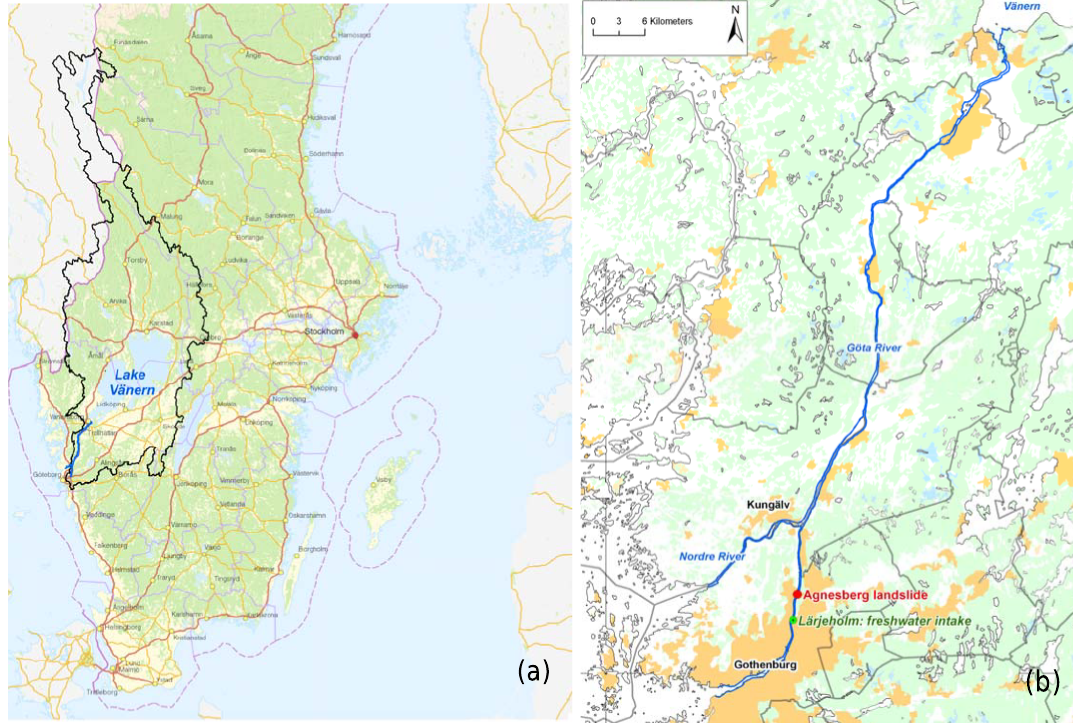
Fig. 2. (a) The G¨ota River and Lake V¨anern catchment. (b) The G¨ota River and the study area showing the locations of the Agnesberg landslide and the freshwater intake. Background maps: Lantm¨ateriet ©